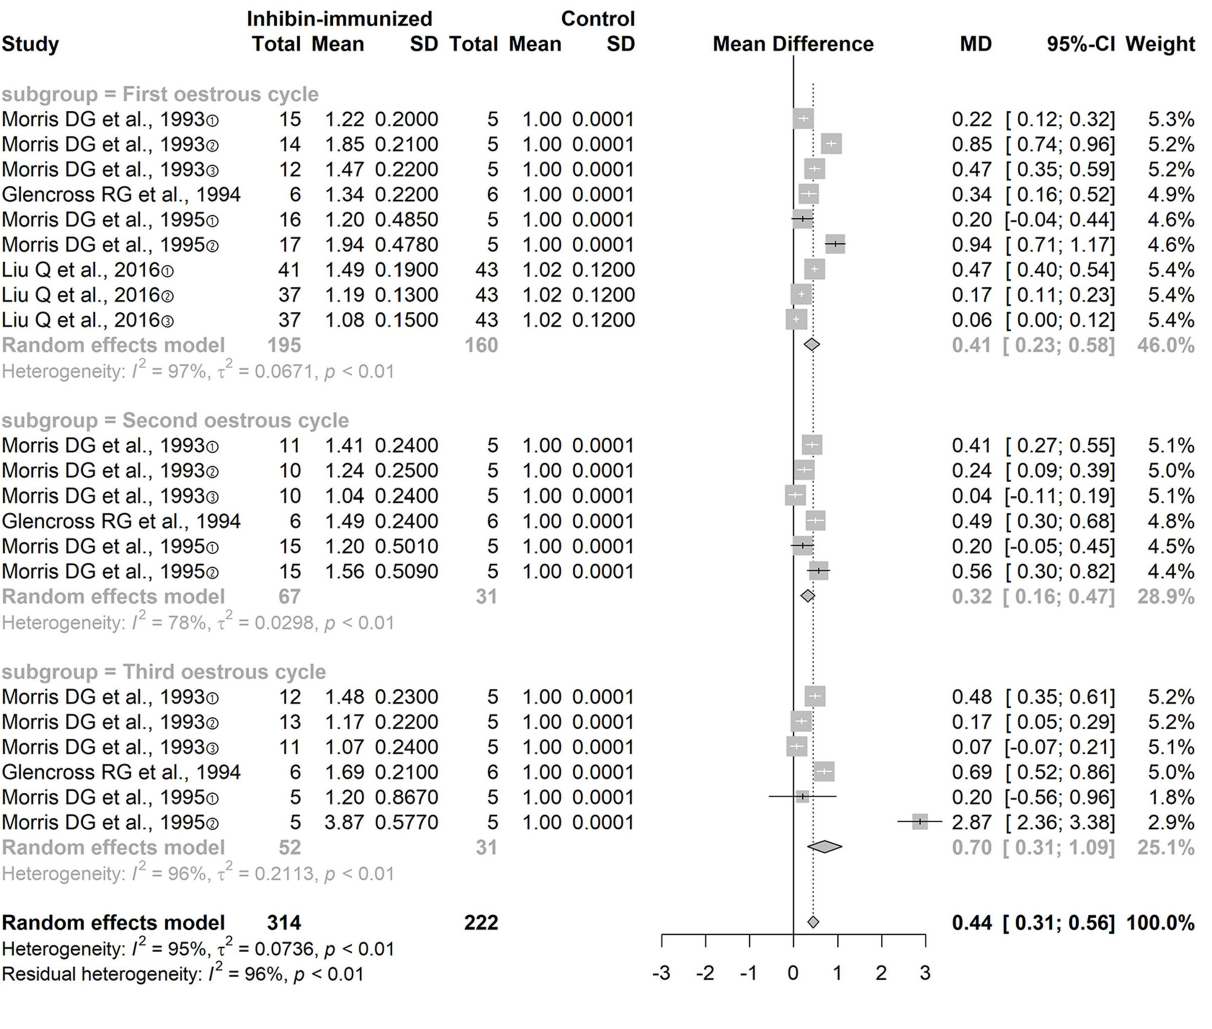
FIGURE 3 | Meta-analysis of ovulation